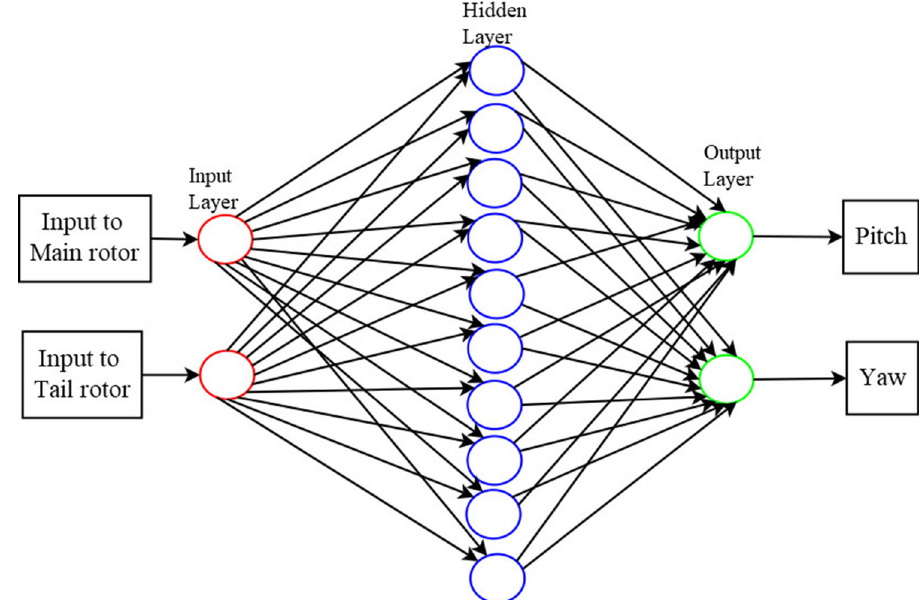
Figure 6. Neural network model used for estimation of pitch and